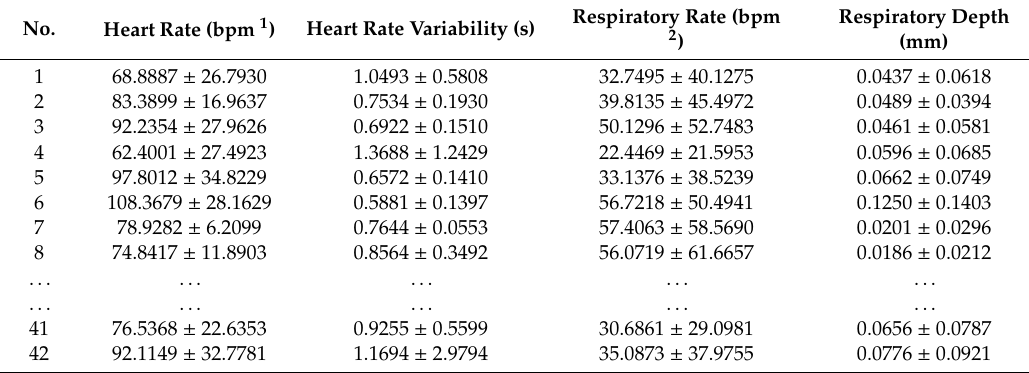
Table 4. ECG and respiratory data after encountering di ff erent